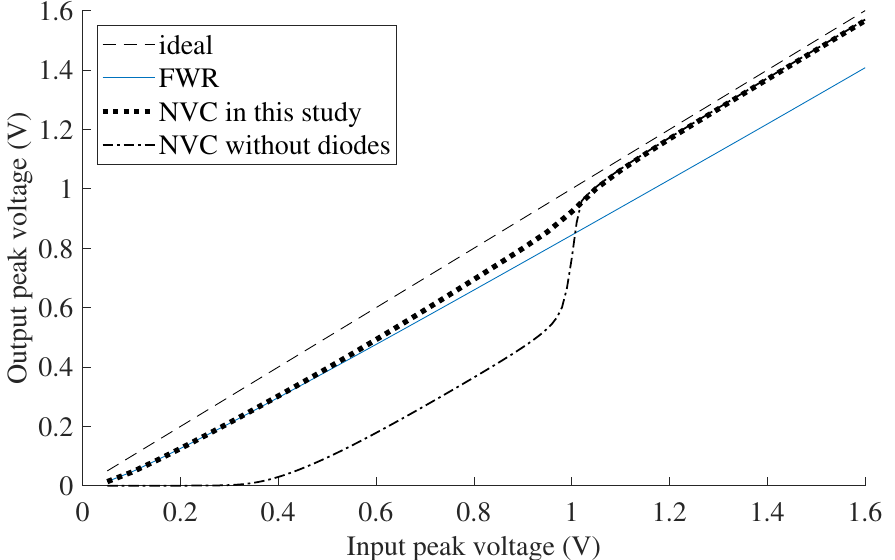
Figure 4. Simulated input and output voltage of the rectifiers using the circuits shown in Figure 3, with an AC voltage source of 7.55Hz and a load of 10k Ω